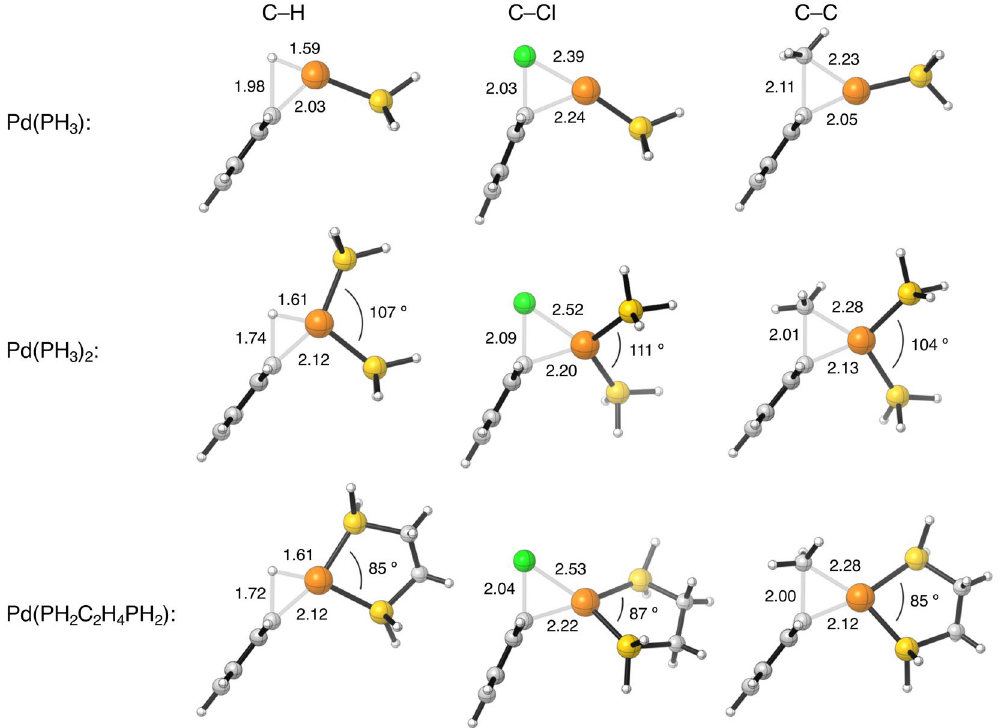
Figure 4. Representative geometries of the transition states (in Å, deg) of the oxidative insertion of Pd(PH 3 ),